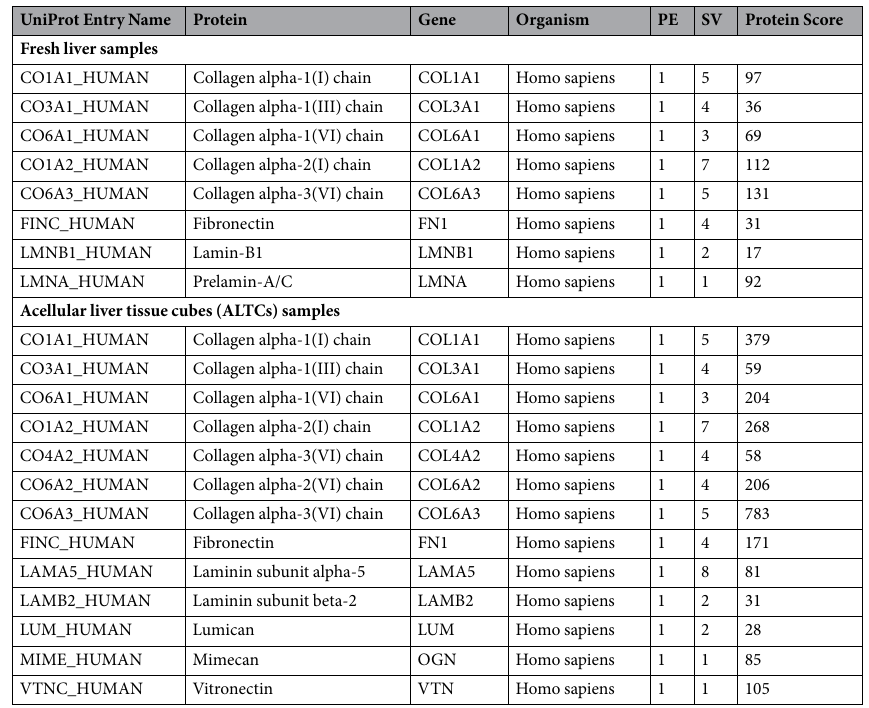
Table 1. Identification of ECM proteins. Proteomic results for fresh liver samples and ALTCs confirming the preservation of the ECM